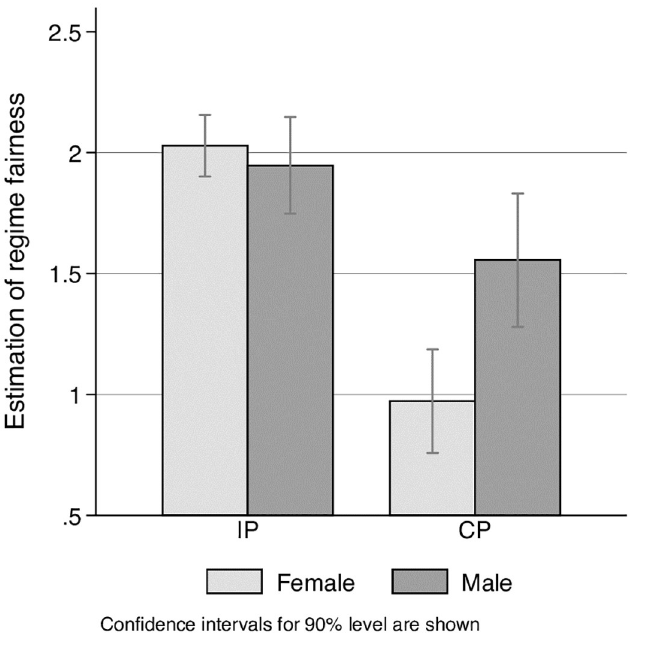
Fig 8. Fairness estimation by gender in two different